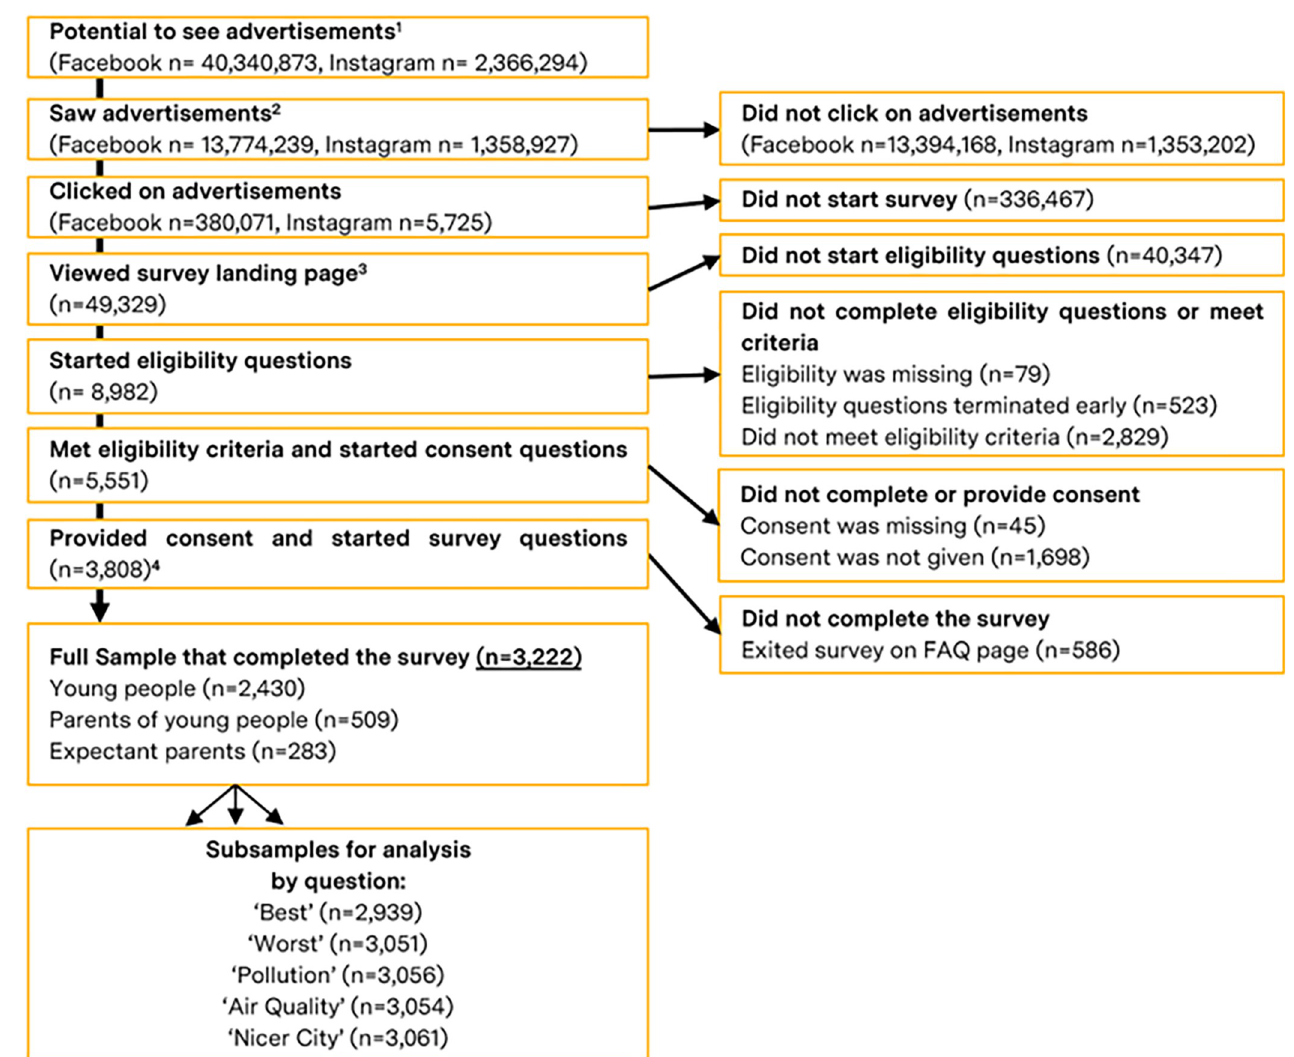
Fig 2. Creation of full sample and subpopulations. 1 The number of individual social media users on each platform that fit the desired demographics of the target population and could be potentially shown the advertisement during the paid advertising campaign. 2 The number of social media users on each platform that were shown an advertisement during the campaign. 3 The number of social media users that clicked on the advertisement on either social media site and were successfully transferred to the survey landing page on Typeform.com to begin eligibility and informed-consent questions. Not all social media users targeted by the paid advertising campaign were eligible or gave consent to participate in the survey. 4 The number of eligible and consenting survey participants who could potentially complete the full